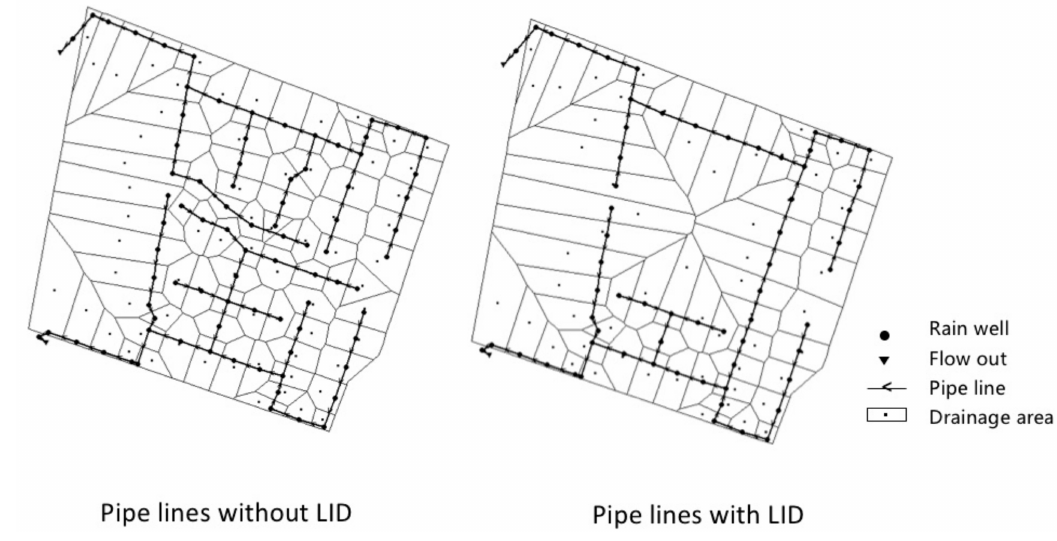
Figure 8. Drainage System.